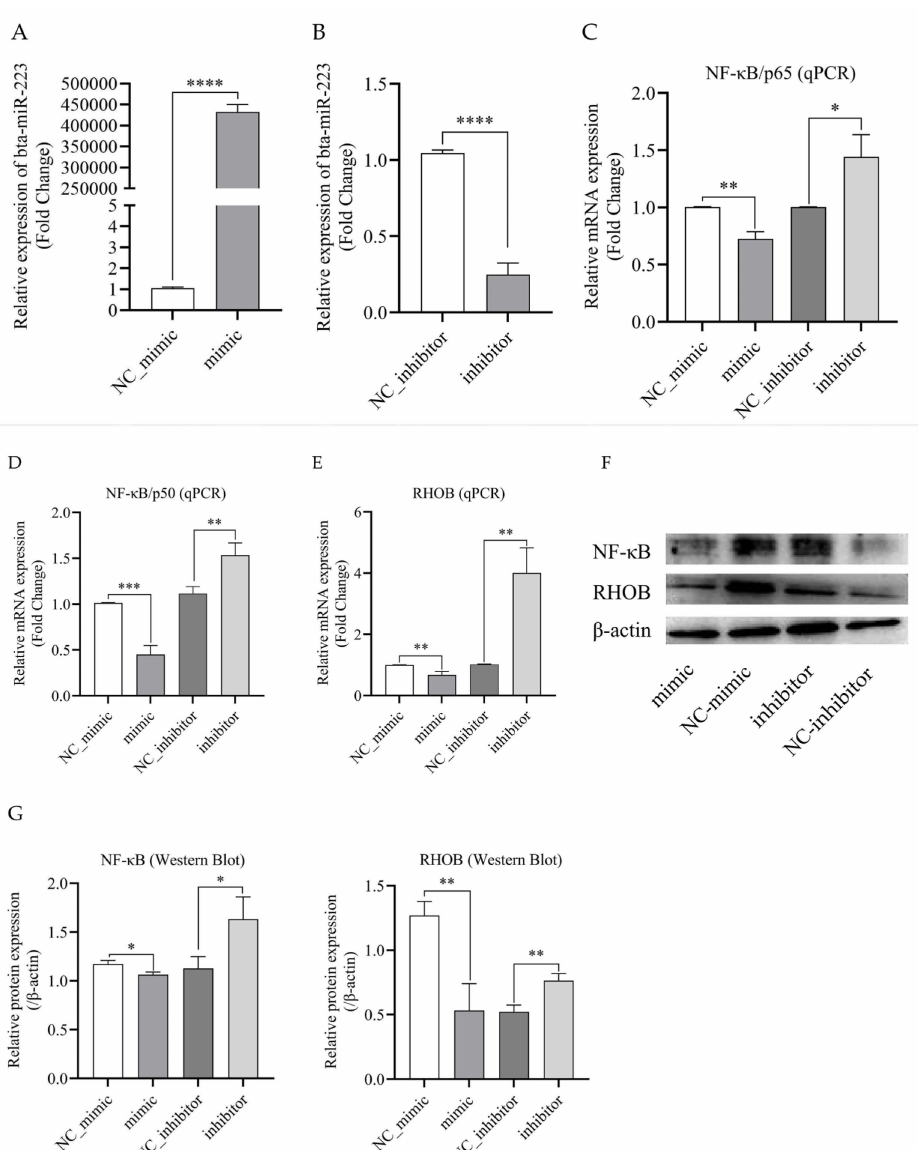
Figure 4. Bta-miR-223 inhibits the expression of RHOB and NF- κ B in bMECs. The bMECs were transfected with bta-miR-223 mimic or NC_mimic, or either inhibitor or NC_inhibitor. Then, 48 h after transfection, the expression levels of genes and proteins were detected by performing qPCR and Western blot, respectively. ( A ) The transfection efficiency of bta-miR-223 mimic was detected by performing qPCR. ( B ) The transfection efficiency of bta-miR-223 inhibitor was detected by performing qPCR. ( C ) qPCR analysis of NF- κ B/p65 in bMECs transfected with bta-miR-223 mimic or inhibitor. ( D ) qPCR analysis of NF- κ B/p50 in bMECs transfected with bta-miR-223 mimic or inhibitor. ( E ) qPCR analysis of RHOB in bMECs transfected with bta-miR-223 mimic or inhibitor. ( F , G ) Western blot analysis of NF- κ B and RHOB protein level expressions in bMECs transfected with bta-miR-223 mimic or inhibitor. Western blot images of NF- κ B and RHOB from the same total protein were analyzed using Image J software. The density quantification of Western blot was normalized to that of the same batch β -actin in order to perform a comparative analysis. The experimental results are displayed as the mean ± SEM. * p < 0.05, ** p < 0.01, *** p < 0.001, **** p <